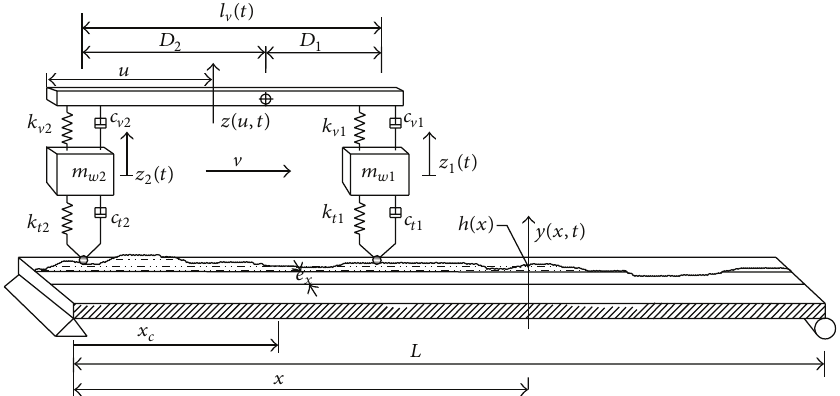
Figure 1: Bridge-vehicle